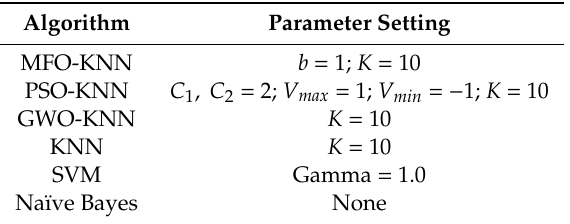
Table 1. Parameter settings for validation.